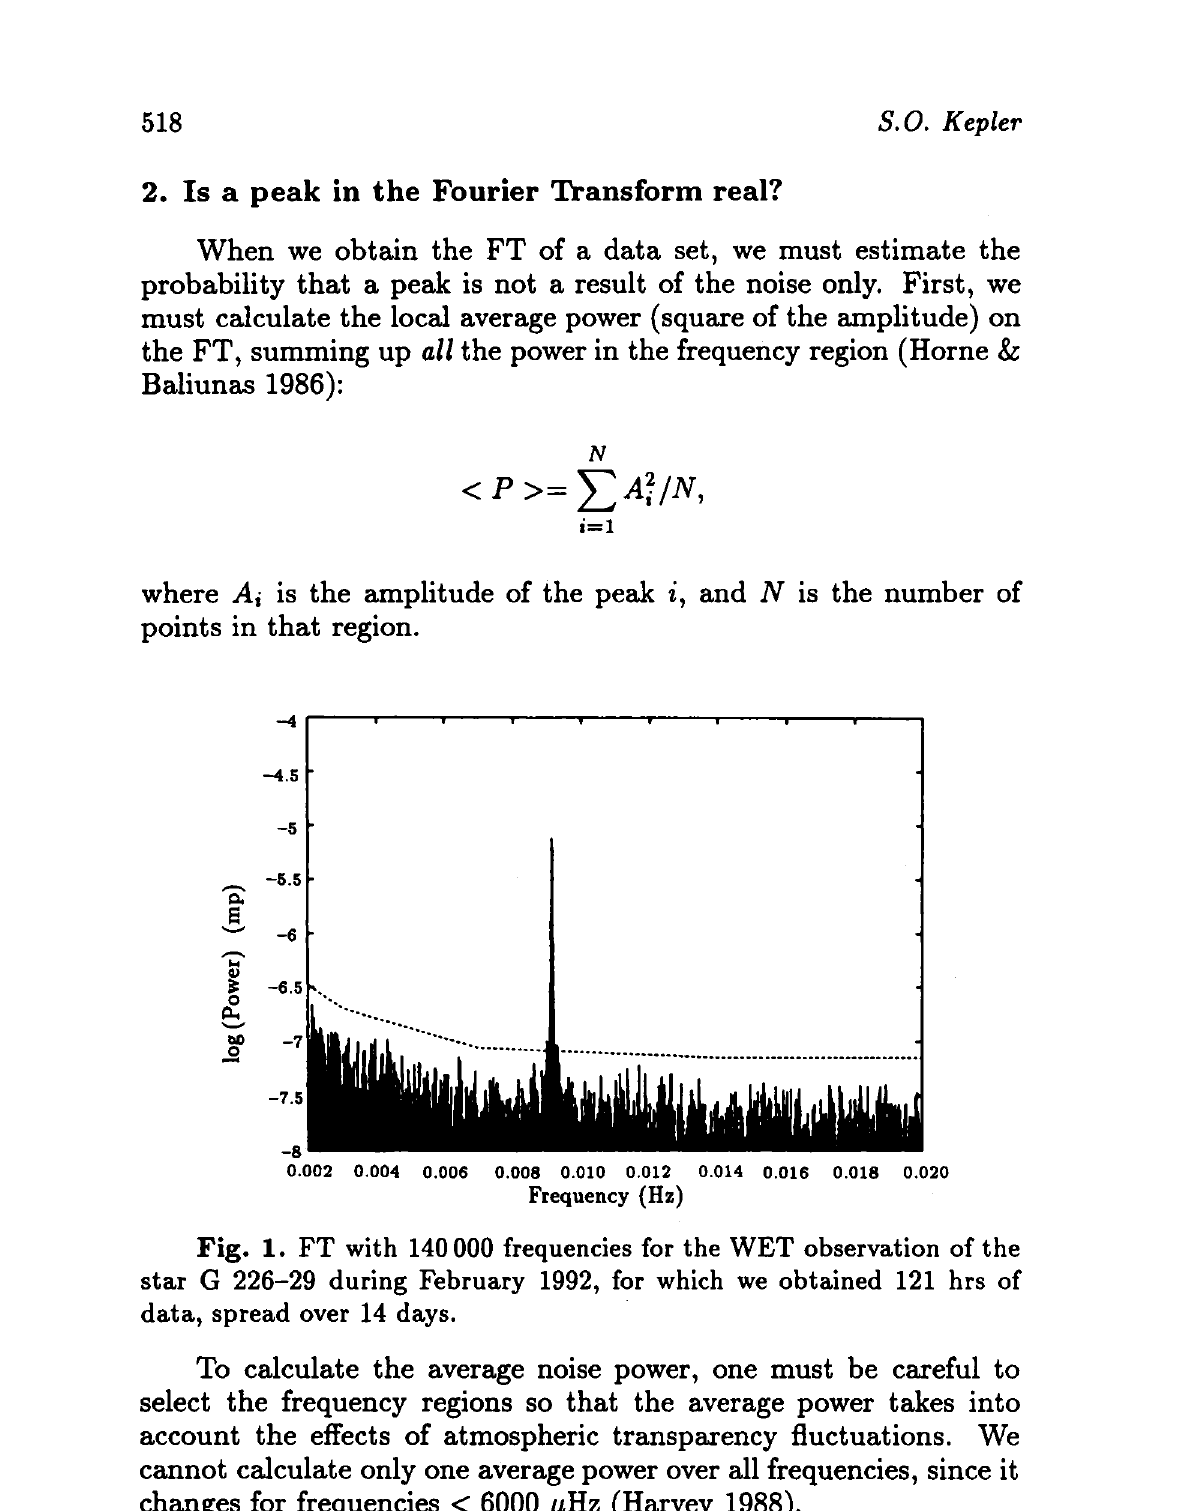
Fig. 1. FT with 140 000 frequencies for the WET observation of the star G 226-29 during February 1992, for which we obtained 121 hrs of data, spread over 14